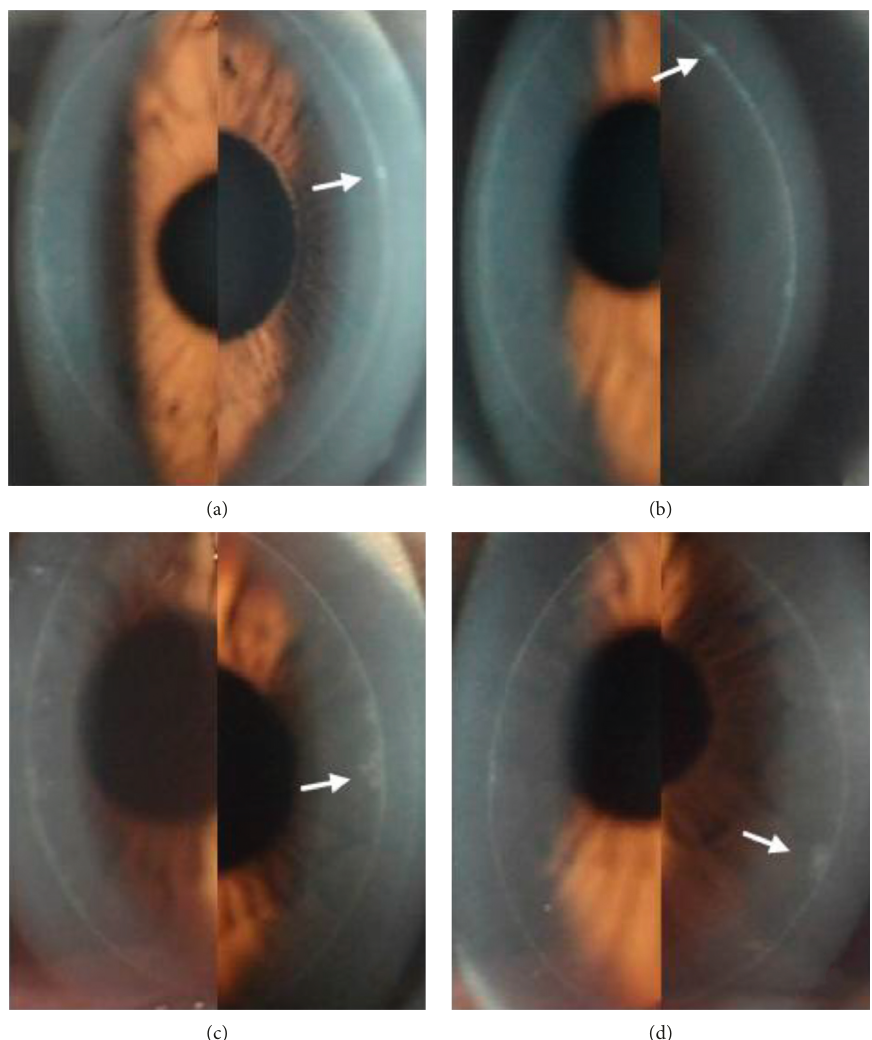
Figure 2: Corneal flap margin and adjacent regions photographed by slit-lamp biomicroscopy at 6 months after surgery. A smooth circumferential band with a small, highly reflective focal scar (white arrow) on the nasal side in the non-BCL-treated right eye (a) and one with a similar scar (white arrow) on the temporal side in the BCL-treated left eye (b) of a patient. A narrow circumferential band with a partially spiculated edge (white arrow) on the nasal side in the non-BCL-treated right eye (c) and one with a partially spiculated temporal side (white arrow) in the BCL-treated left eye (d) of a